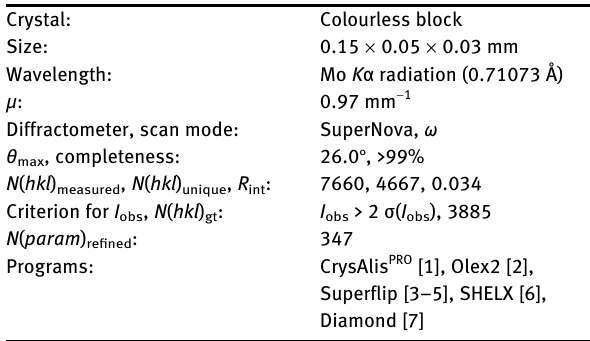
Table  : Data collection and